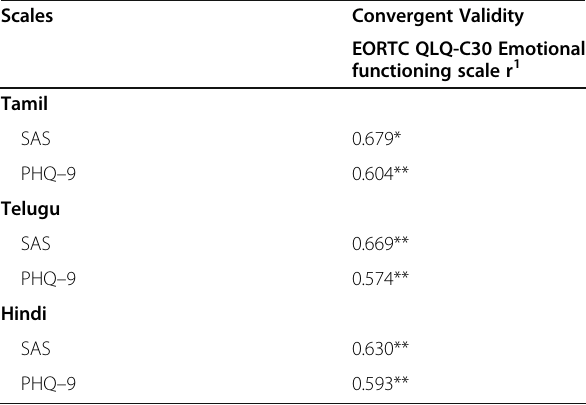
Table 5 Scale level analyses – convergent validity across Tamil, Telugu,